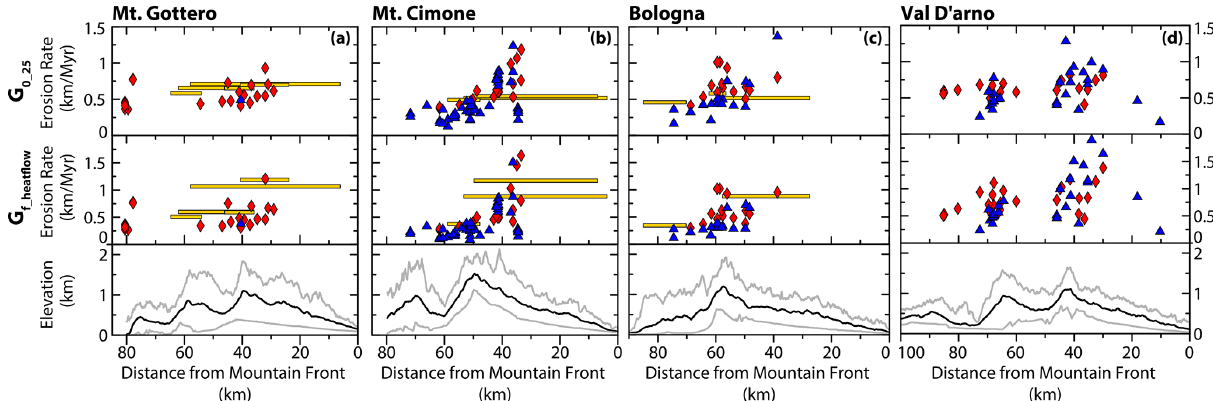
Figure 8. Erosion rates for AHe, bedrock AFT, and detrital AFT thermochronometers calculated from G 0_25 (top row, a–d ) or calculated with G f_heatflow (middle row, a–d ). The length of the detrital AFT boxes reflects the distance from the sample location to the catchment headwaters where the erosion rate is valid. Swath profile locations are shown in Fig. 3a. In the Bologna swath profile, one AHe sample could not be resolved for an erosion rate with G f_heatflow